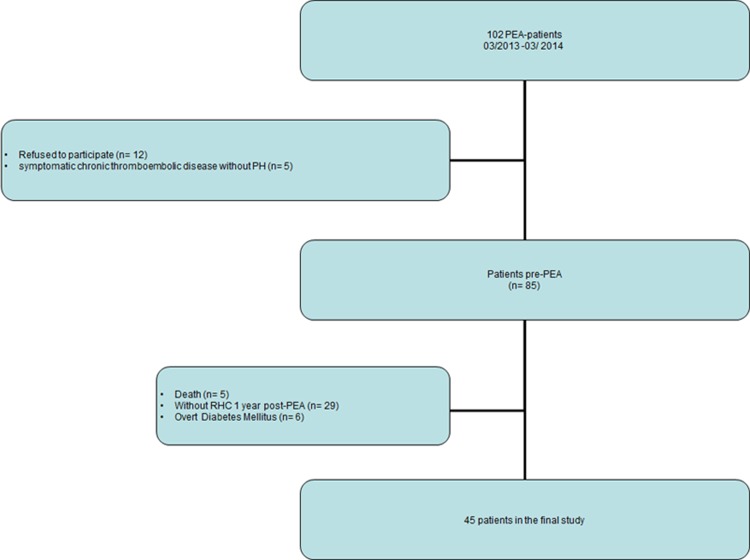
Flow chart of patient selection.RHC: right heart catheterization; PEA: pulmonary endarterectomy; PH: pulmonary hypertension.